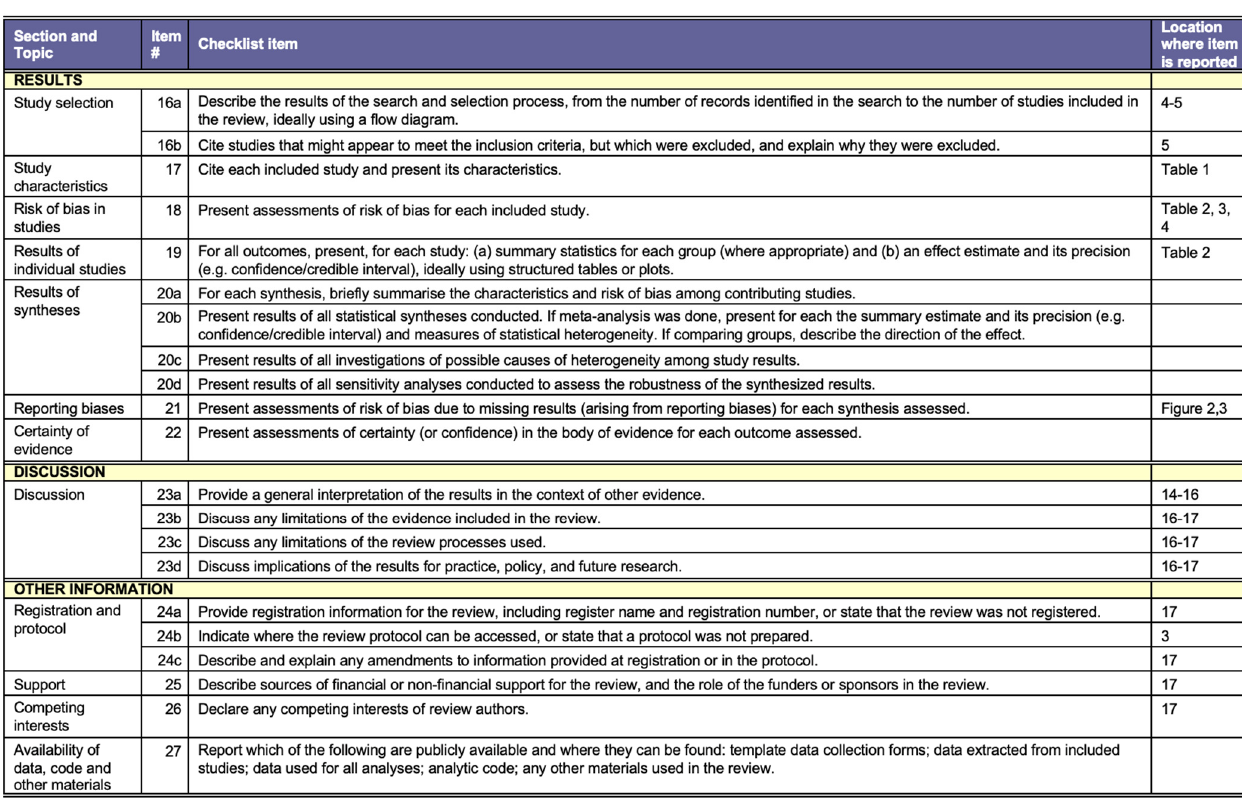
Figure A2. PRISMA Checklist [39].